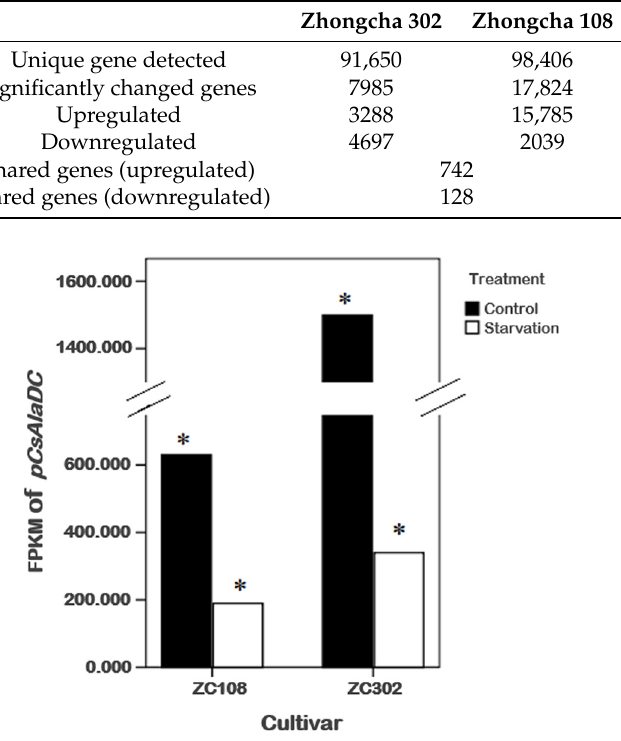
Figure 3. Effects of nitrogen starvation on gene expression levels of pCsAlaDC in the roots of tea plants. * represents a significant difference at p < 0.05.